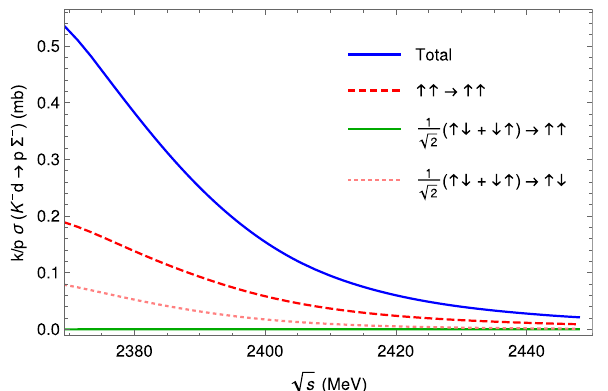
Fig. 3 Contribution from several spin transitions in k